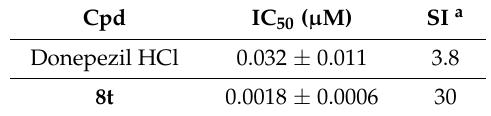
Table 2. Inhibition (IC 50 values in µ M) of the activity of Hs AChE by donepezil and its analogue 8t